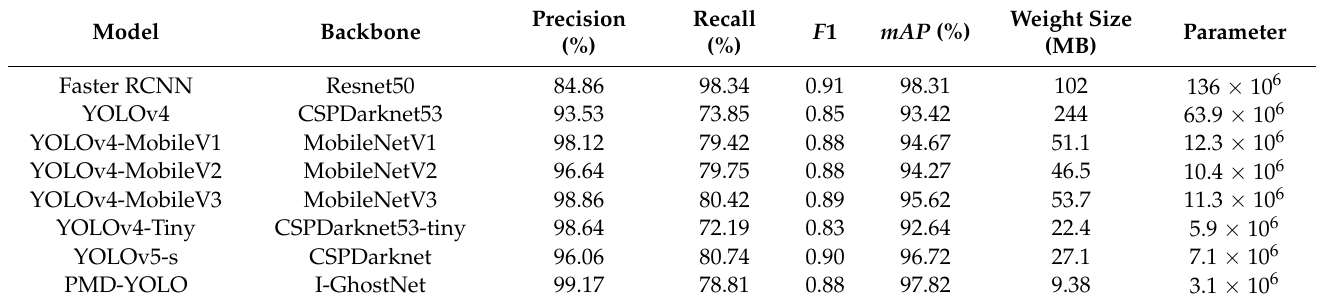
Table 3. Performance comparison of PMD-YOLO and other detection